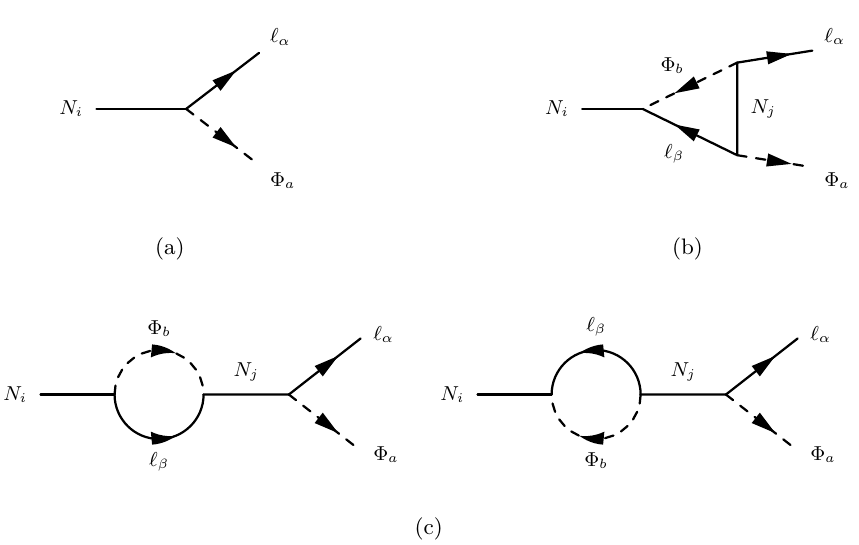
Figure 1 . Usual diagrams contributing to the CP asymmetry in N i → ‘ α Φ a through interference. (a) Tree-level contribution ∼ O ( Y 2 ) . (b) Vertex contribution ∼ O ( Y 4 ) . (c) Wavefunction contributions ∼ O ( Y 4 )